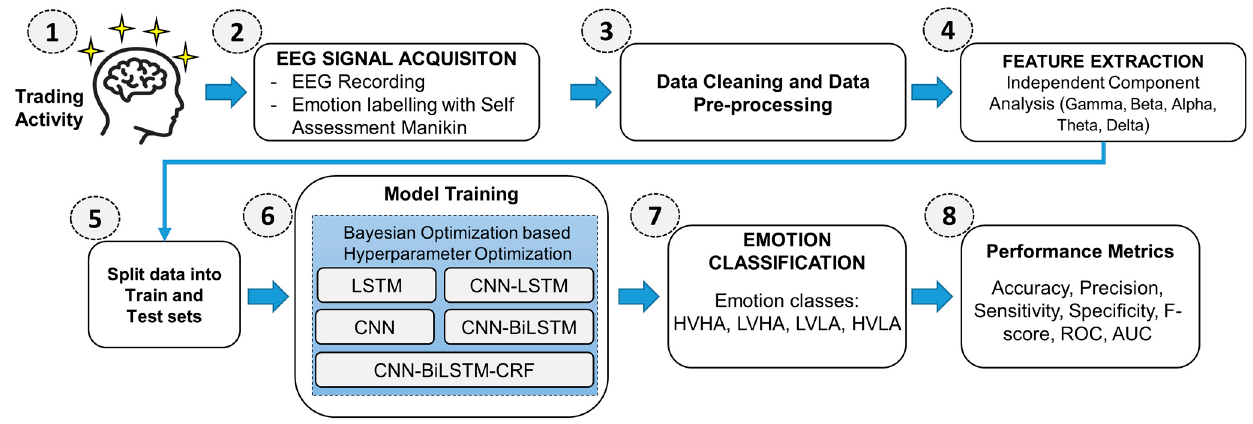
Figure 3. Workflow schematic of the proposed emotion classification framework.